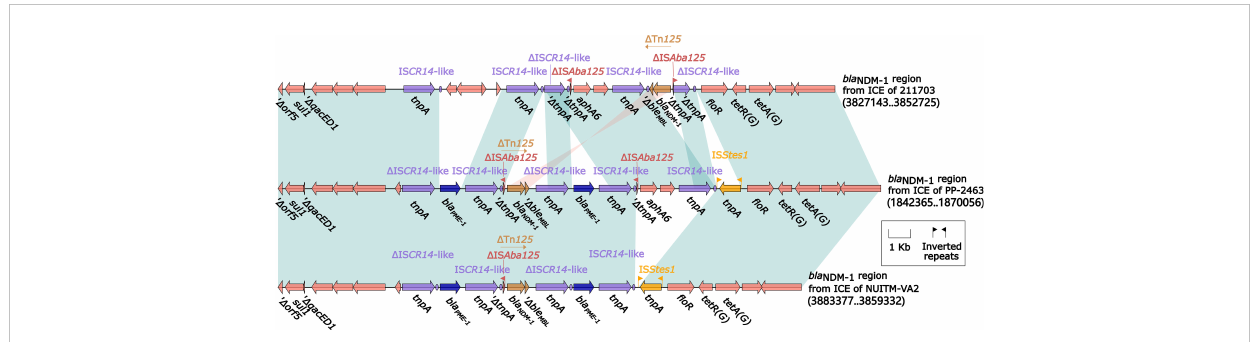
FIGURE 4 Comparison of ICEs harboring bla NDM-1 region from 211703, PP-2463, and NUITM-VA2. Genes were denoted by arrows. Genes, mobile genetic elements, and other features were colored based on their functional classi fi cation. Shading denoted regions of homology (nucleotide identity > 95%). A single quotation mark in front of the gene name indicated pseudogene.